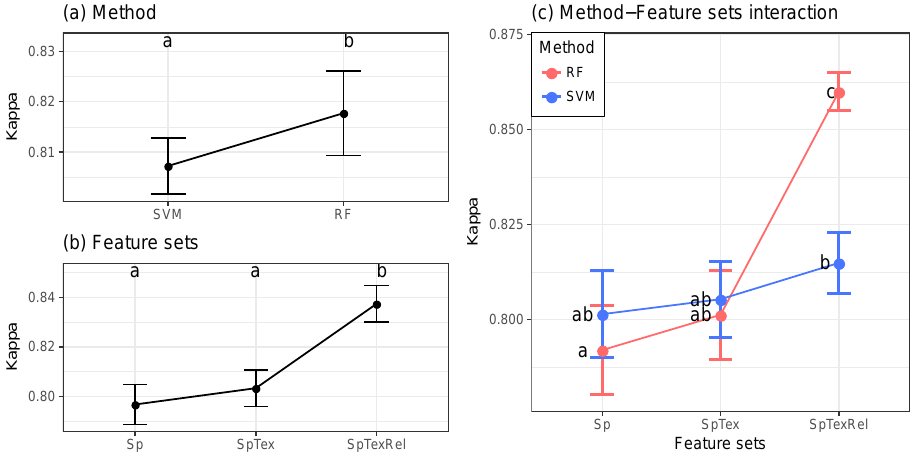
Figure 5. Main effects and simple effects of significant factors (mean and 95% confidence interval). Significantly different groups (Tukey–Kramer contrast using heteroscedasticity-consistent covariance matrix of the parameters (HC3), alpha = 0.05) are represented by different letters. Number of classifications: